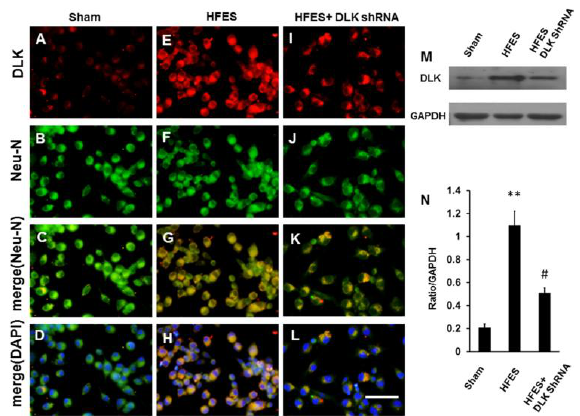
Figure 4. Illustration of DLK expression in dorsal root ganglion cells culture subjected to high frequency electrical stimulation (HFES) and DLK shRNA treatment. ( A ) Expression of DLK in dorsal root ganglion cells culture. ( B ) Co-localization with Neu-N. ( C ) Merged imaging of ( A , B ). ( D ) Merged imaging of ( A – C ). ( E ) Expression of DLK in dorsal root ganglion cells culture by high frequency electrical stimulation. ( F ) Co-localization with Neu-N. ( G ) Merged imaging of ( E , F ). ( H ) Merged imaging of ( E , F , G ). ( I ) Expression of DLK in dorsal root ganglion cells culture by high frequency electrical stimulation followed by DLK shRNA. ( J ) Co-localization with Neu-N. ( K ) Merged imaging of ( I , J ). ( L ) Merged of ( I , J , K ). ( M ) Illustration of Western blot imaging ( N ). Quantitative analysis of Western blot analysis. ** p < 0.001 indicated high frequency electrical stimulation group relative to sham; # p < 0.05 indicated the DLK shRNA treated group relative to high frequency electrical stimulation group; Bar length = 200 µ m.